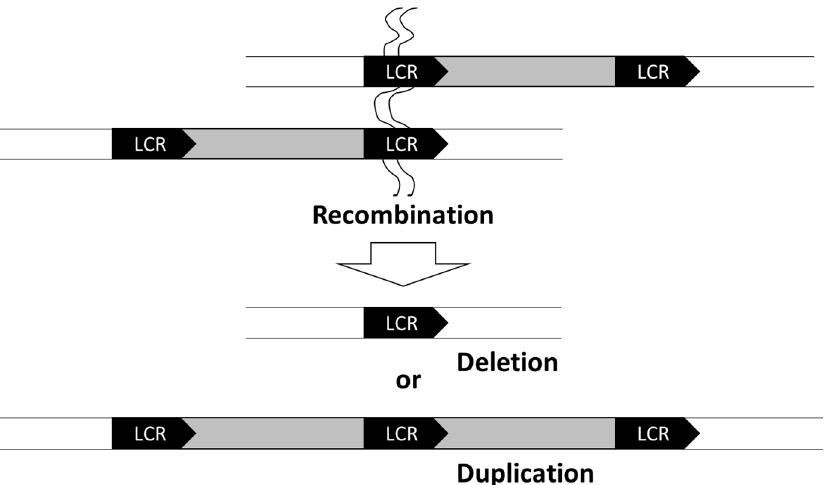
Figure 1. Schematic representation of the mechanism of nonallelic homologous recombination. Deletions and duplications of the regions of interest (grey rectangles) can be caused by nonallelic homologous recombination triggered by the presence of low-copy repeats (LCRs). Table 1. Classical microdeletion syndromes and reciprocal duplications.